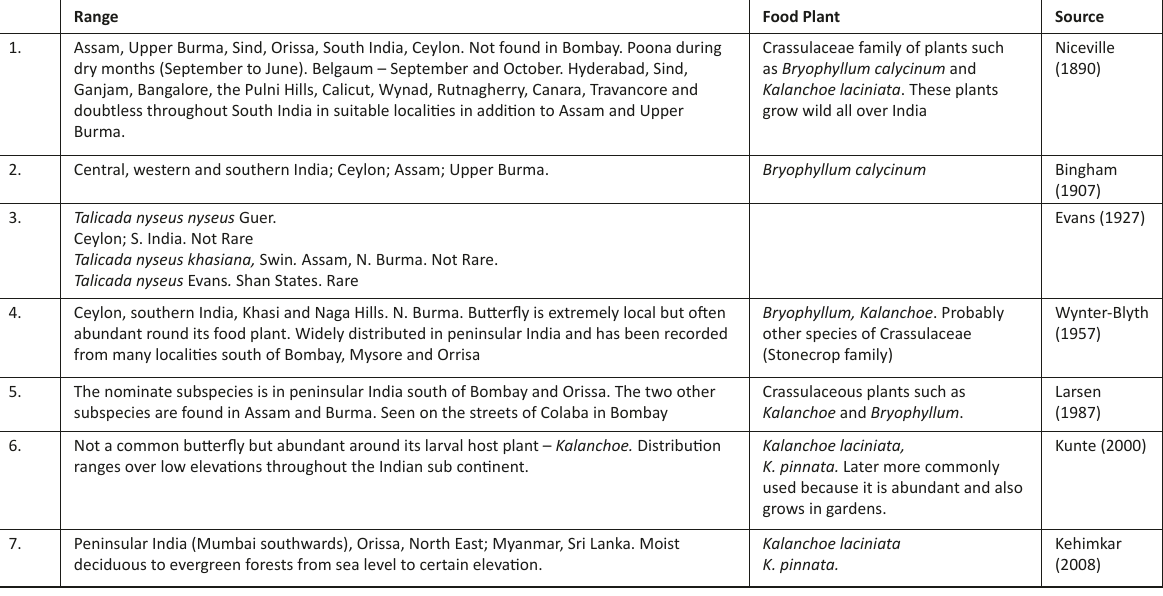
Table 1. Documented range and larval food plants of Red Pierrot Butterfly Talicada nyseus Range Food Plant